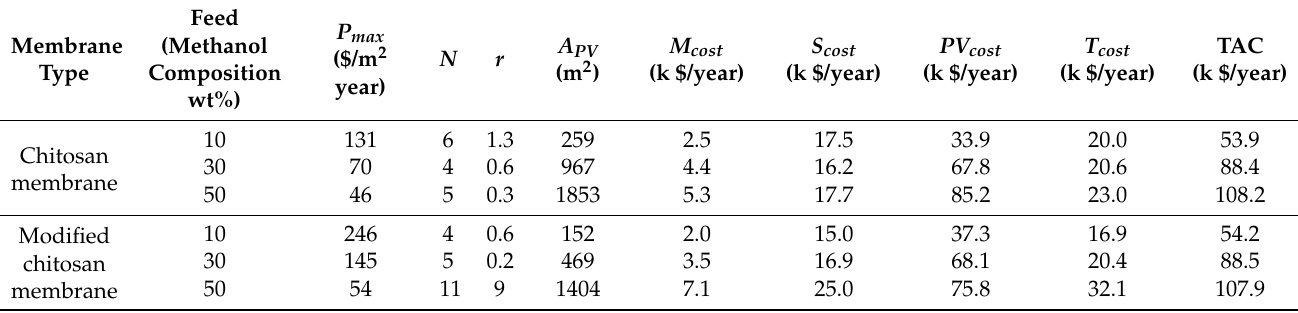
Table 3. The optimal integration process parameters of the three feed components are obtained by using the modified membrane, when the feed flow rate is 100 kg/h.